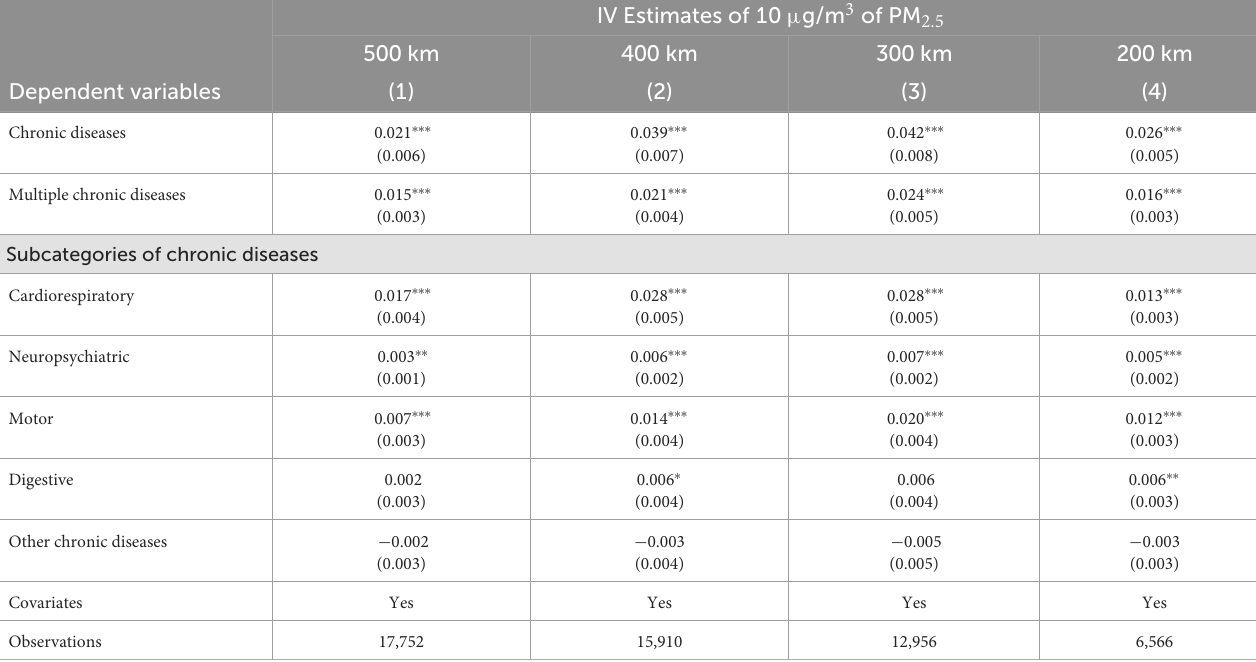
TABLE 4 Effect of alternative bandwidths on regression results, parametric estimates.